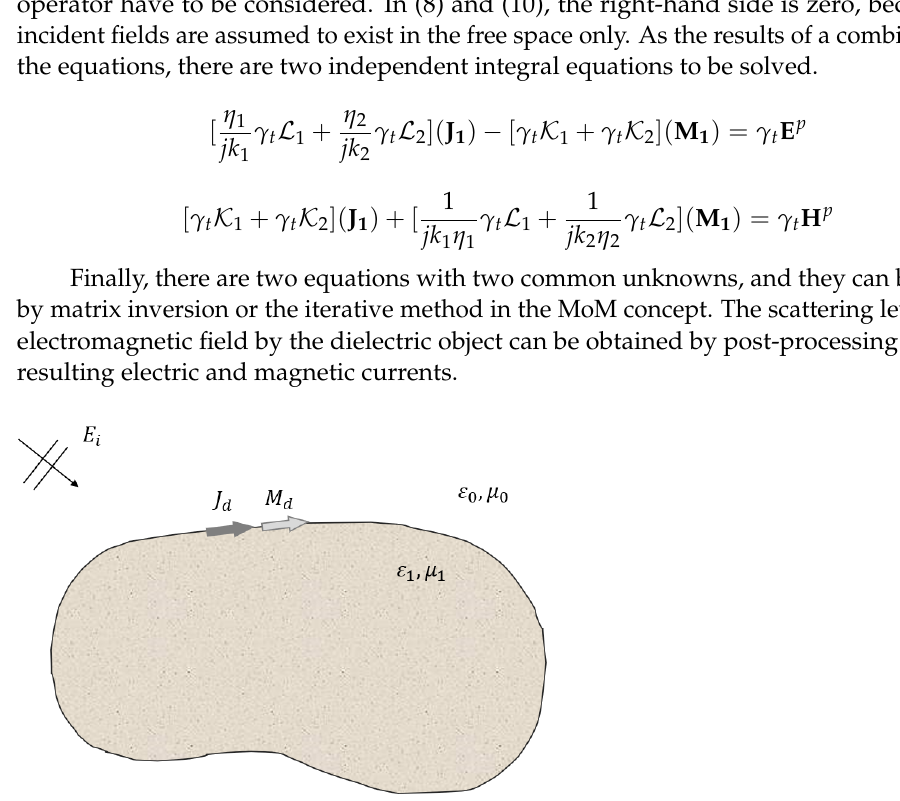
Figure 1. Equivalent electric and magnetic currents on the boundary of the dielectric